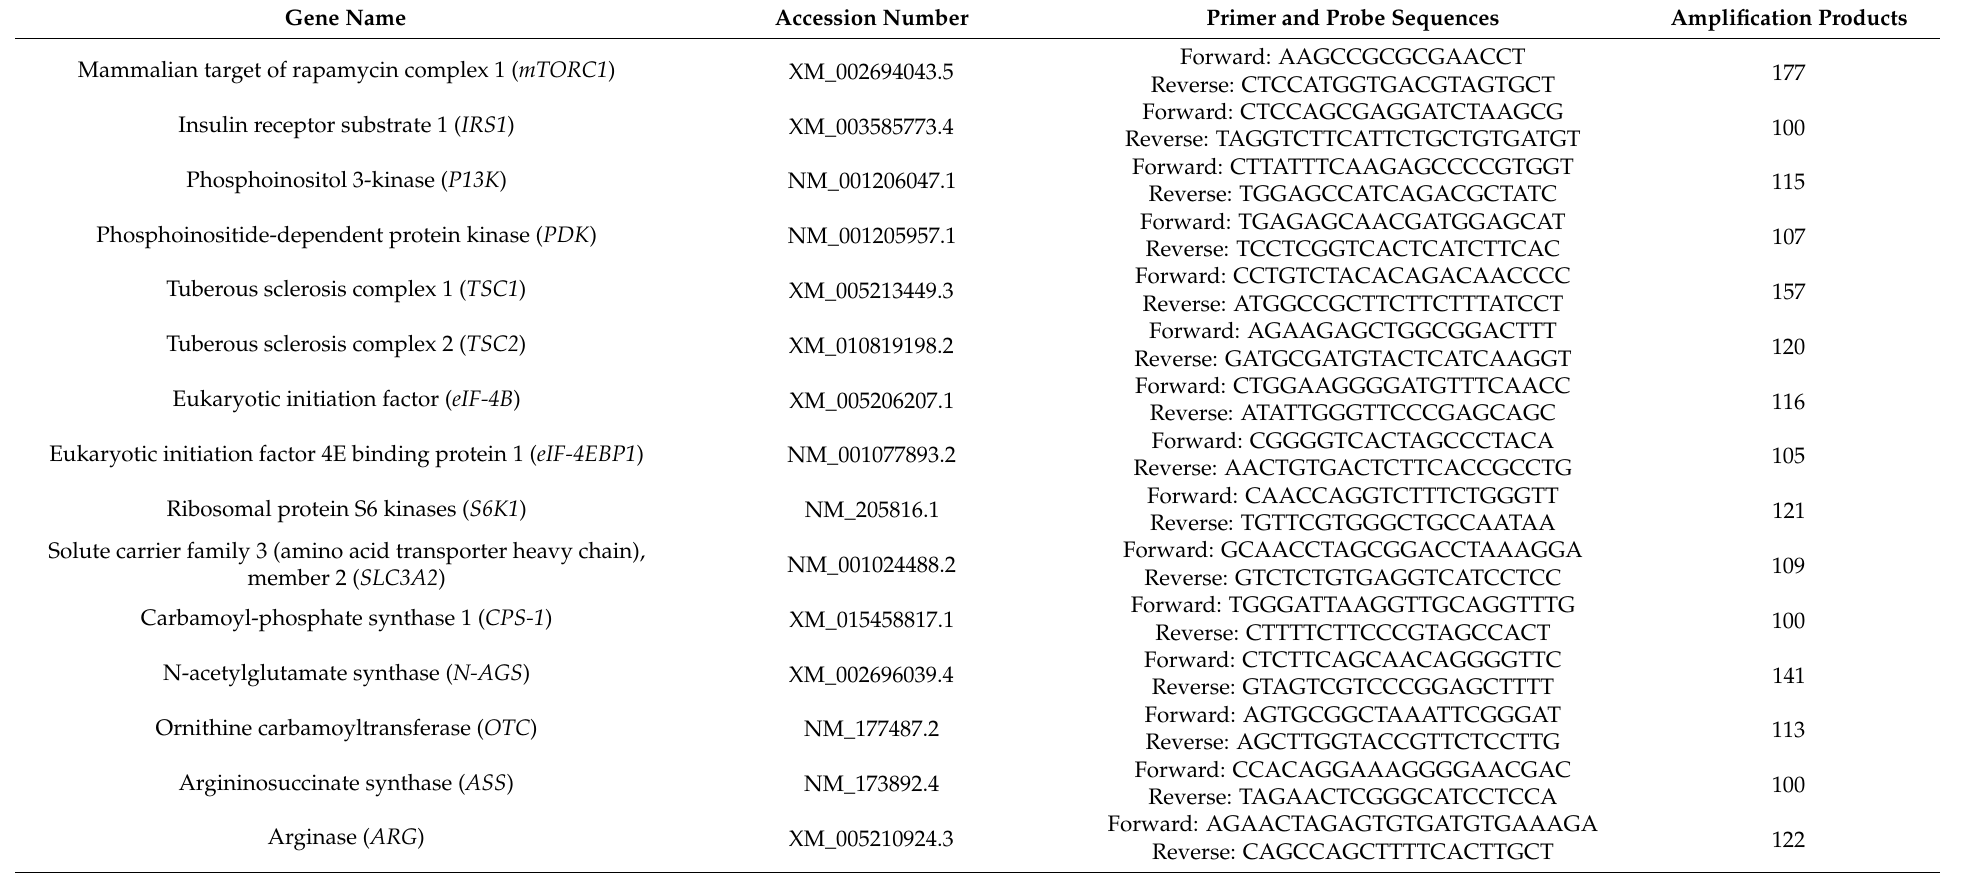
Table 2. Primer of target genes in